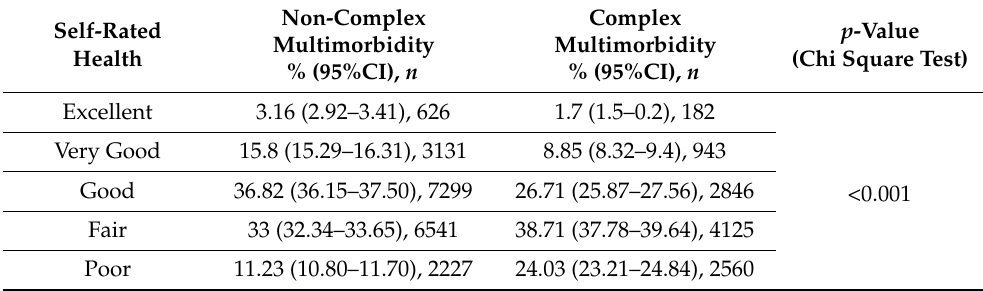
Table 5. Self-rated health of participants with multimorbidity vs. complex multimorbidity. Self-Rated Health